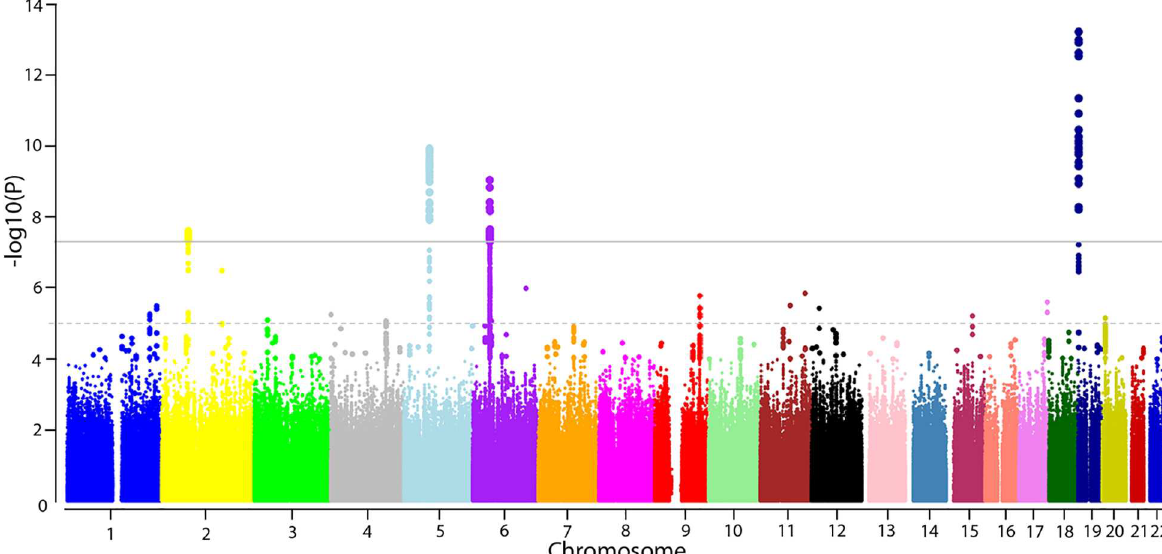
Fig 1. Manhattan plot for association of mJSW in the discovery phase. The -log10 P values, for each of the 2.5 milliontests performed as part of the genomewide association of minimal joint space width of the hip (mJSW), plotted against their position per chromosome. Full results of the discovery GWAS are accessiblethrough www.glimdna.org. The gray solid horizontal line corresponds to the genome-wide significant threshold (P = 5x10-8). The dotted grey line corresponds to the selection for replicationthreshold (P = 1x10 -5